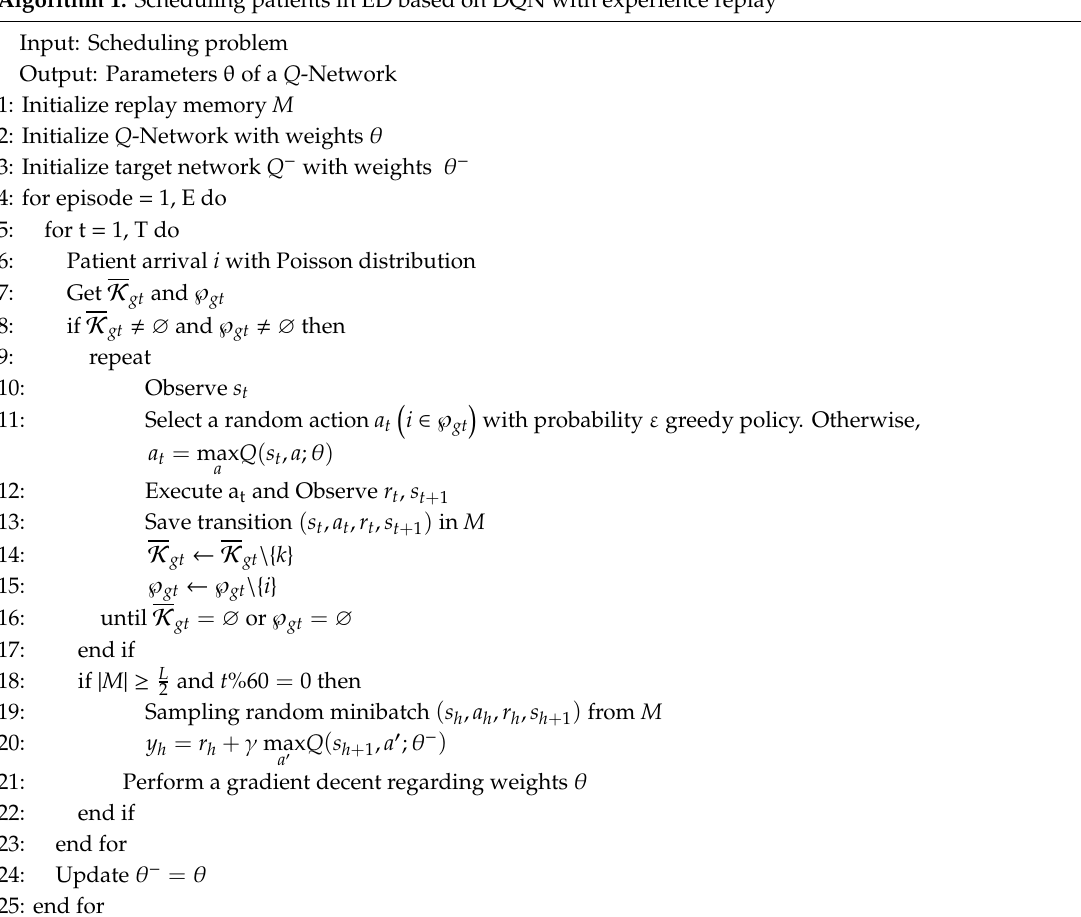
Algorithm 1. Scheduling patients in ED based on DQN with experience replay